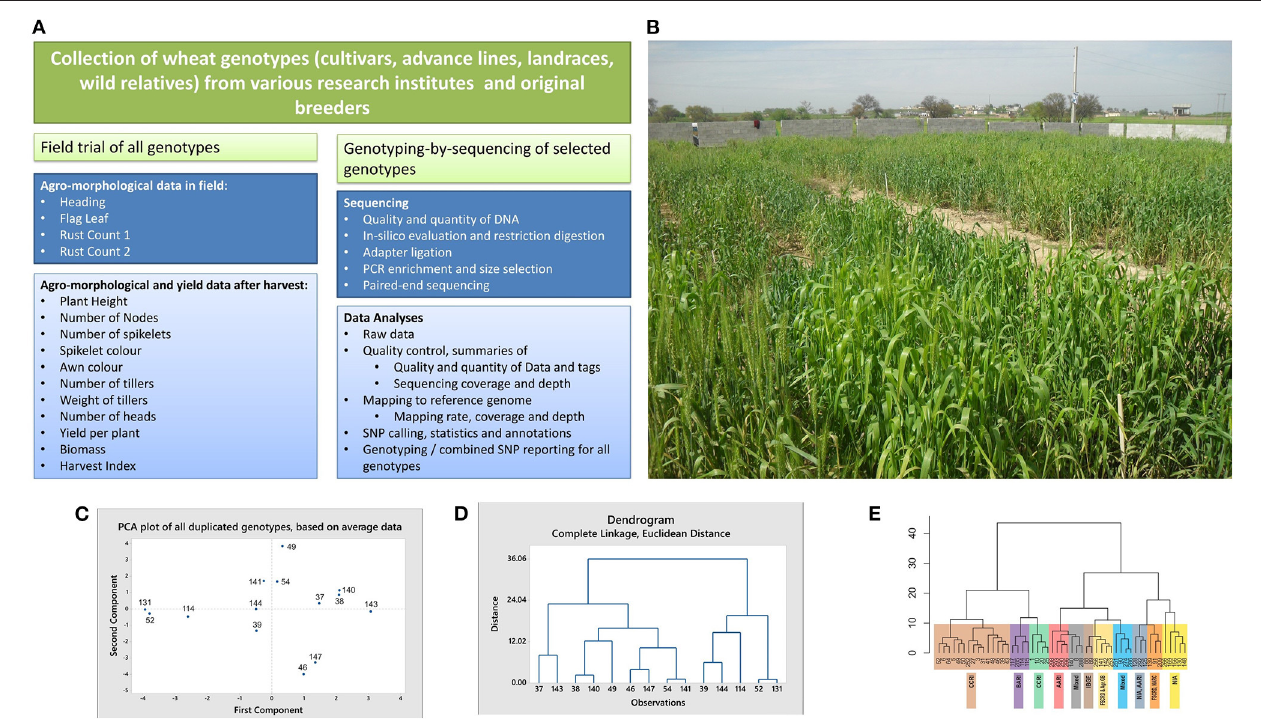
FIGURE 1 | Schematic workflow, field snapshot, multivariate analyses, and dendograms of wheat cultivars. (A) Schematic workflow of the study. (B) A snapshot of the field. Different genotypes visible in the field were cultivated in blocks for recording agro-morphological and yield data. (C,D) Results of the multivariate analyses, showing clustering of the duplicated genotypes. Average data of all plants per genotype was used for these analyses. The duplicate genotypes (IDs in brackets) include Sahar (37 and 143), Faisalabad 2008 (38 and 140), Lasani 2008 (39 and 144), Marvi 2000 (46 and 147), Chakwal 50 (49 and 114), Galaxy (54 and 141), and TD-1 (52 and 131). Except for the genotype Chakwal-50, both the PCA plot (C) and dendrogram (D) tend to cluster together the duplicates in each genotype. (E) Dendrogram based on Ward distances, grouping the genotypes into clusters and sub-clusters. Genotypes collected from individual research institutes tend to cluster together. Detailed methodology is provided in Supplementary Material